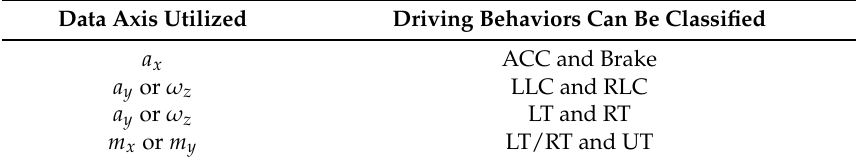
Table 3. Some driving behaviors which can be classified even by the information of a single axis.